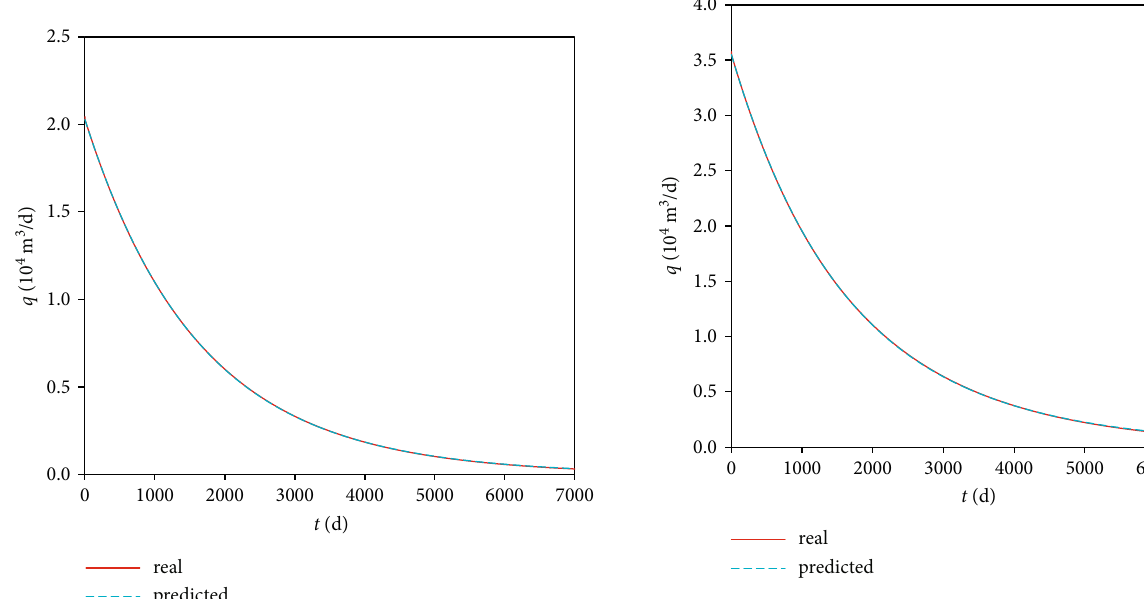
Figure 24: The real q pro fi le and the predicted pro fi le by the hyperbolic decline model for Case